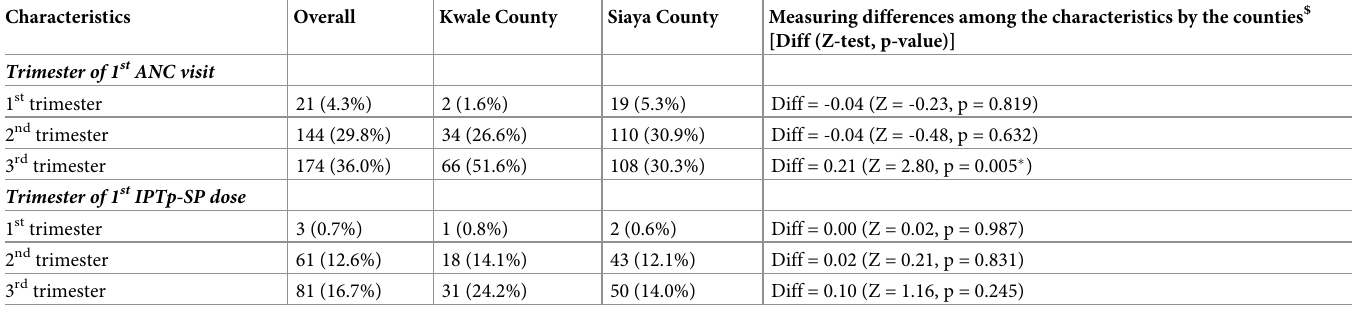
Table 2. Comparison of the first antenatal care visit and intermittent preventive treatment (IPTp-SP) uptake by trimester of the pregnant women in Kwale and Siaya counties, Kenya.